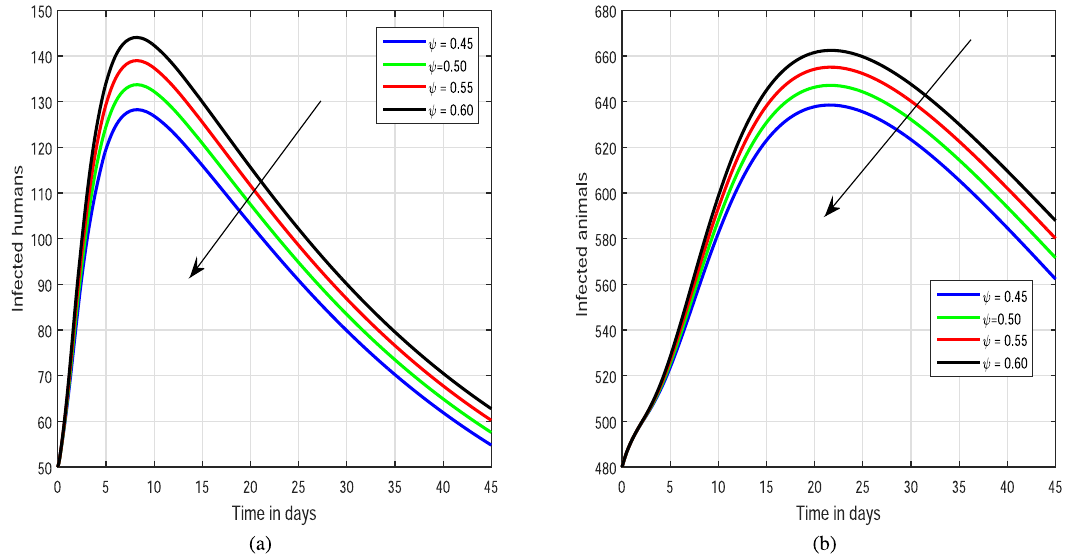
Figure 5: Representation of the time series of the infected individuals of the model ( 9 ) of zoonotic infection with variation of ψ , i.e. = ψ 0.45, 0.50, 0.55 , and